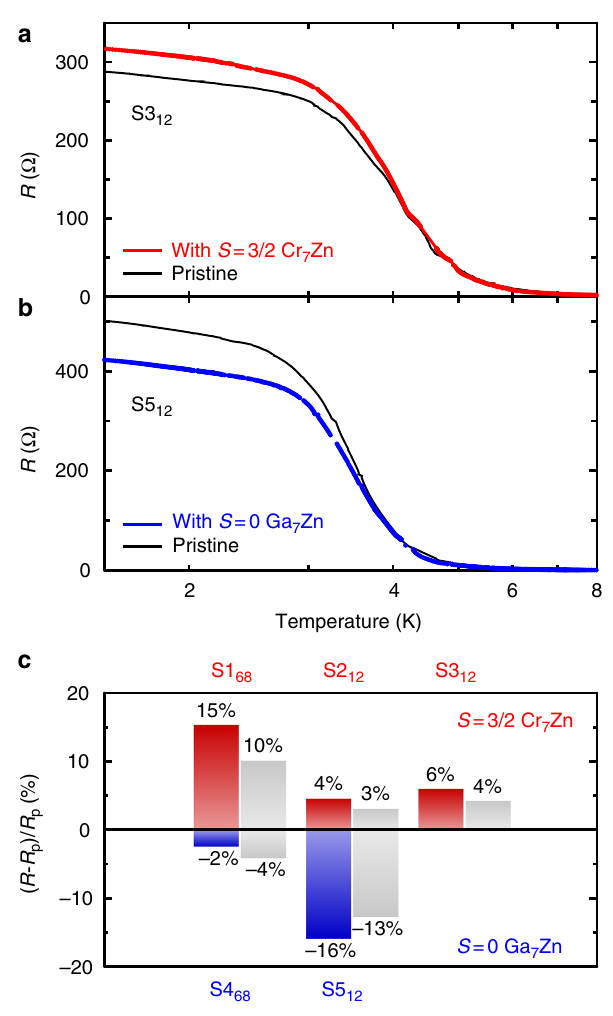
Fig. 4 The change in resistance as a function of temperature under the in fl uence of surface modi fi cation. The effect of the magnetic Cr 7 Zn ( a , red) is to perturbatively increase the resistance at low temperature and Ga 7 Zn ( b , blue) causes a perturbative decrease in resistance at low temperatures. At high temperatures where the electrical transport is dominated by the bulk, surface modi fi cation has no effect. c Graphical representation of the deviation of zero-magnetic- fi eld resistance caused by surface decoration for all samples. The coloured (grey) bars represent the resistance changes at 1.4 K (4.2 K). The measured values of resistance are reproduced